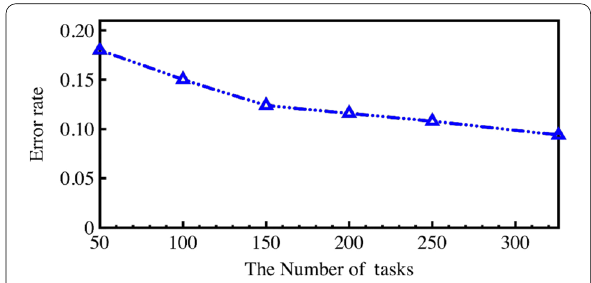
Fig. 8 Error rate under different network scales